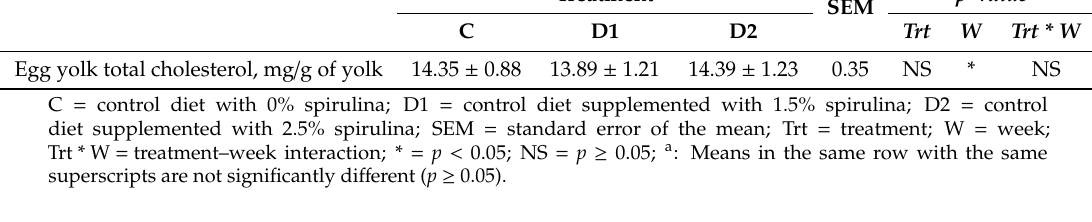
p-Value Treatment SEM C D1 D2 Trt *